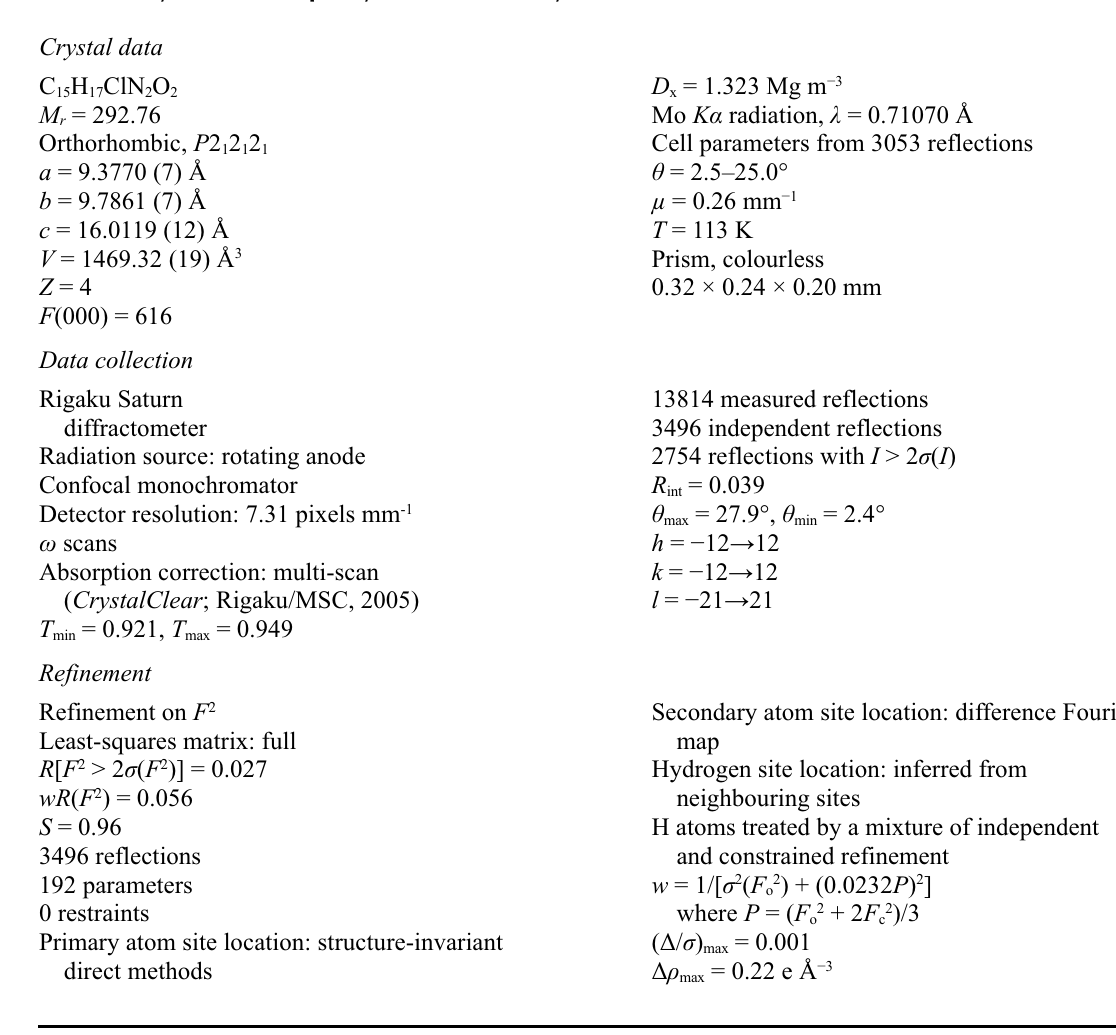
Figure 1 The molecular structure of (I), showing 50% probability displacement ellipsoids and the atom-numbering scheme. N ′ - tert